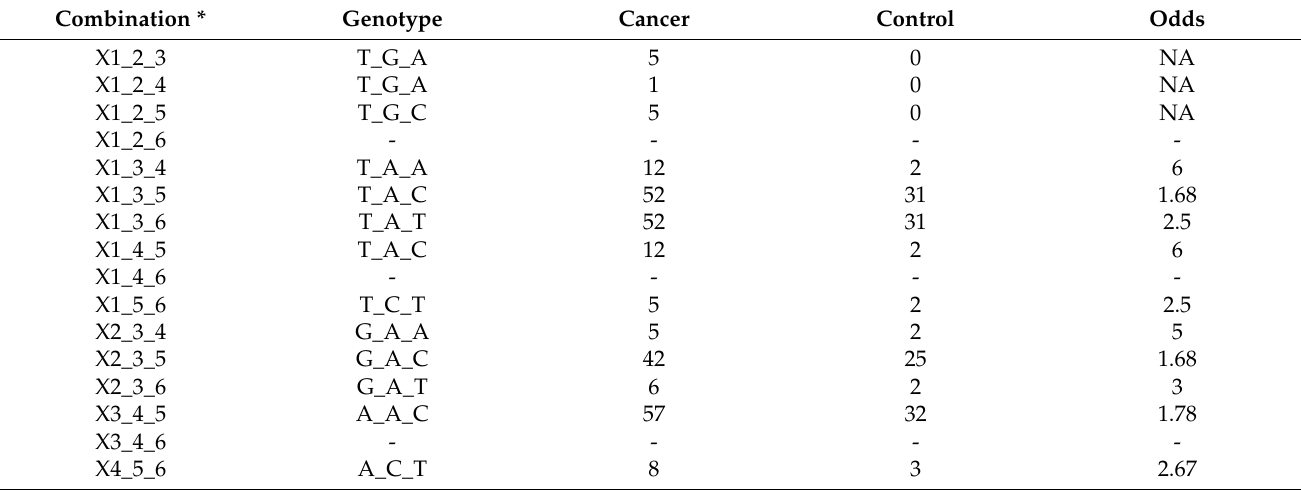
Table 6. Risk alleles three-by-three combination